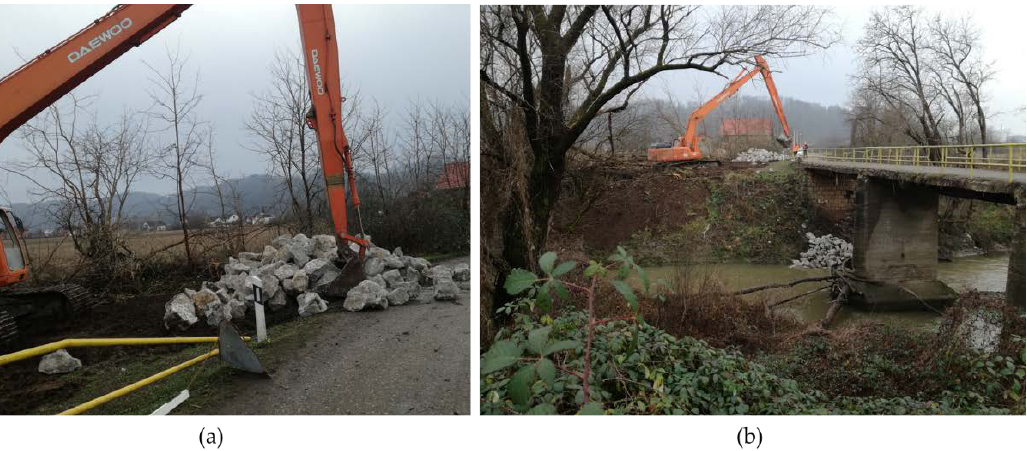
Figure 15. ( a ) Stone material for urgent stabilization; ( b ) placing of the additional weight on the abutment and embankment.